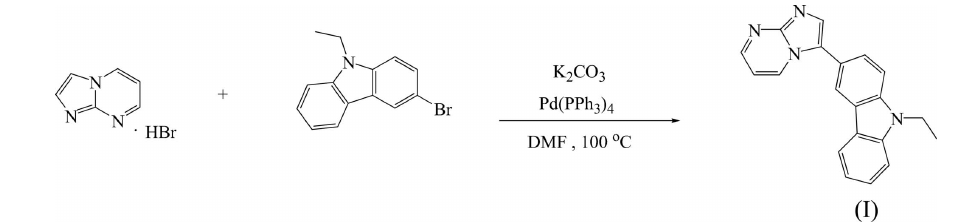
Figure 1 A molecular structure of (I) with 30% probability displacement ellipsoids, showing the atom-numbering scheme employed.